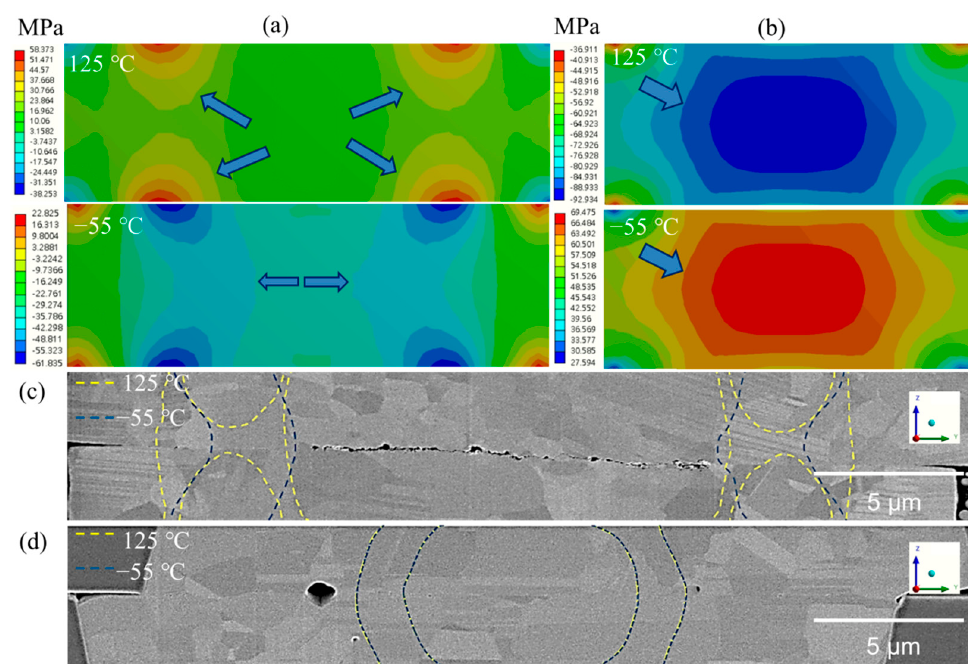
Figure 7. Comparison of numerical and experimental observations for two different dielectric structures: ( a ) PBO/UF/PBO and ( b ) SiO 2 . The yellow and blue dotted lines in the FIB images (( c ), PBO/UF/PBO) and ( d ), SiO 2 ) represent the stress gradient lines at 125 °C and − 55 °C, respectively.